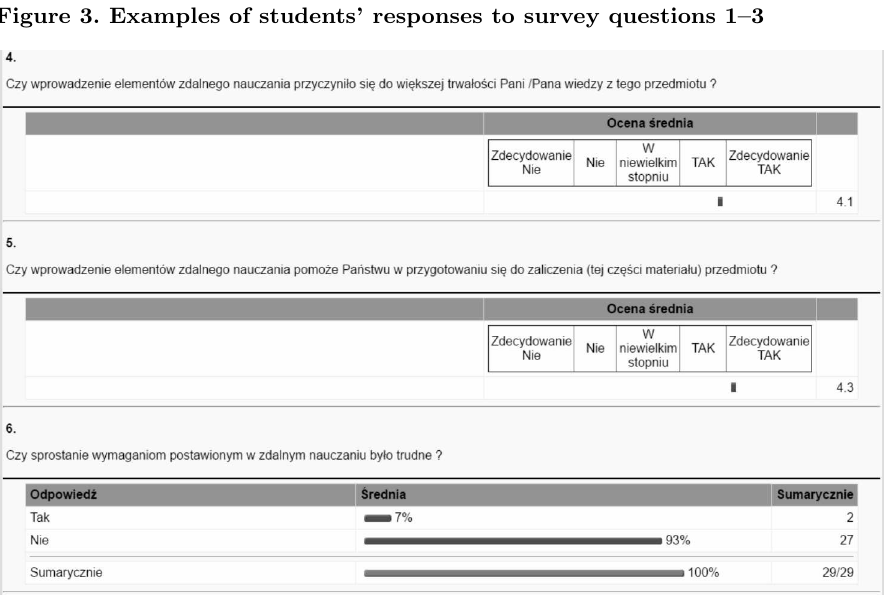
Figure 4. Examples of students’ responses to survey questions